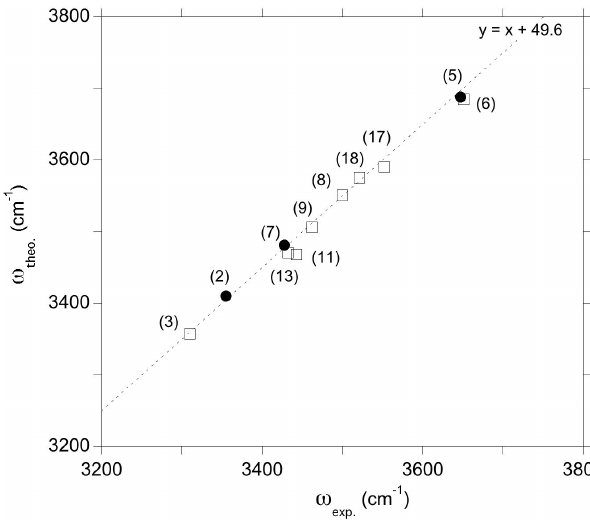
Figure 7. Theoretical stretching frequency of OH groups as a func- tion of experimental frequency for the series of relevant models. The labels refer to the models of Table 1. The 1 : 1 correlation has been obtained only using models (5), (7) and (2) (full circles). Alignment of the other models (open squares) in this correlation supports the proposed interpretations (see